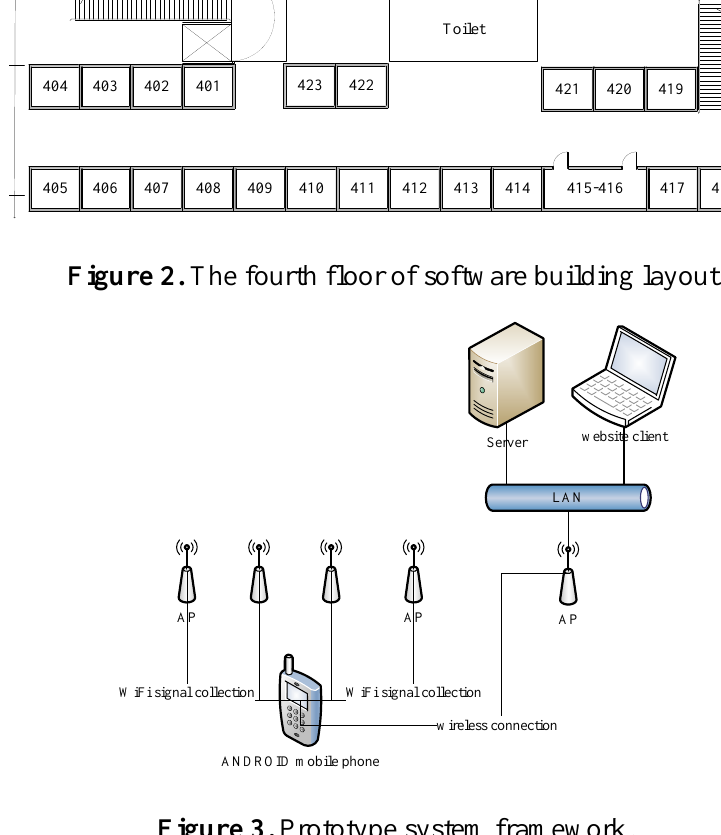
Figure 3. Prototype system